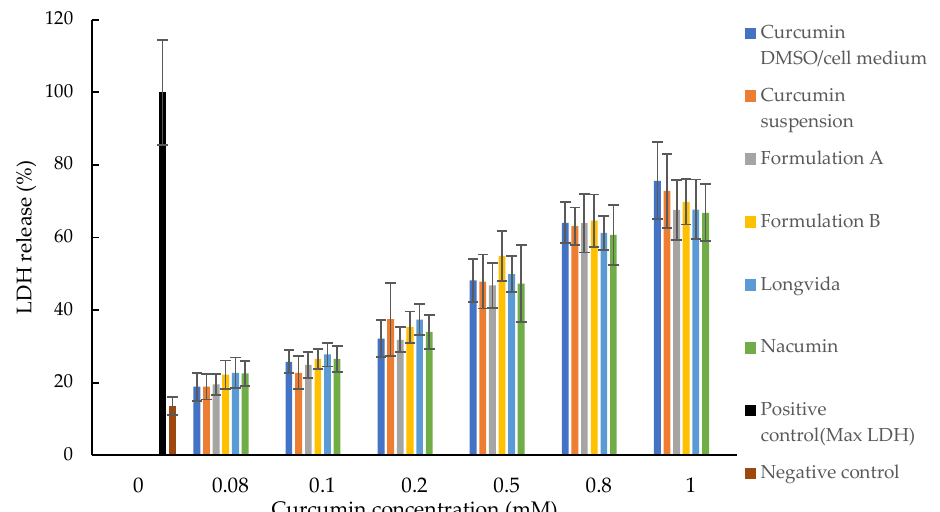
Figure 10. The percentage of LDH released from Caco-2 cells when exposed to each formulation, with equivalent curcumin concentrations from 0.08 to 1 mM ( n = 18, mean ± SD).